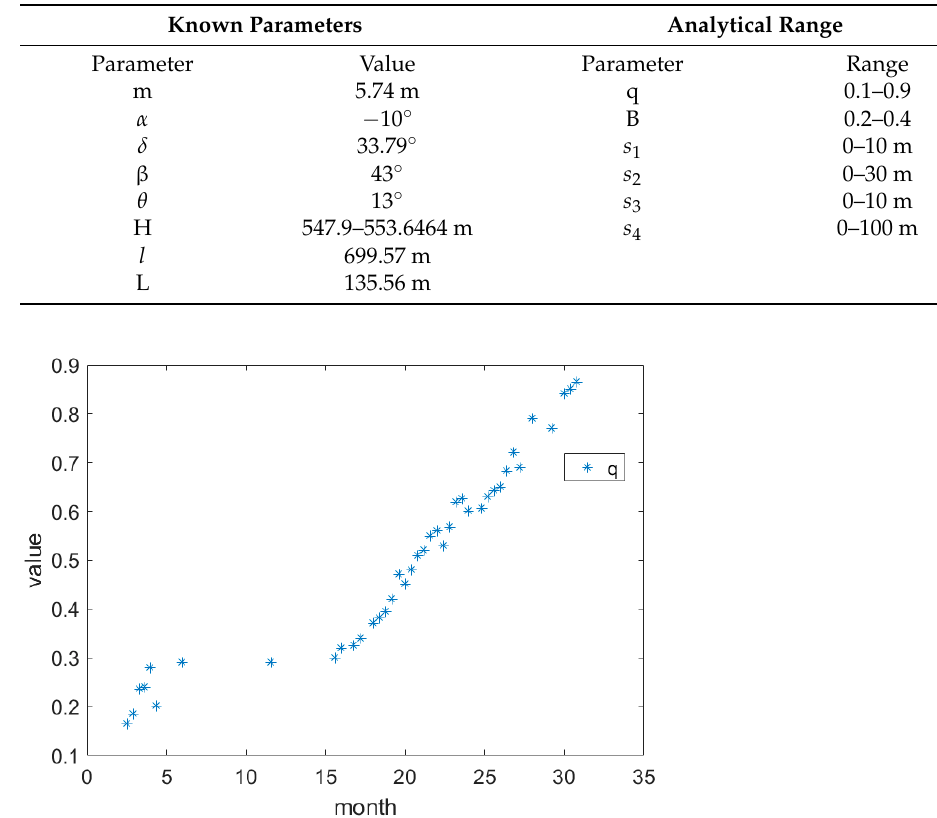
Table 2. Value and analytical range of the parameters.